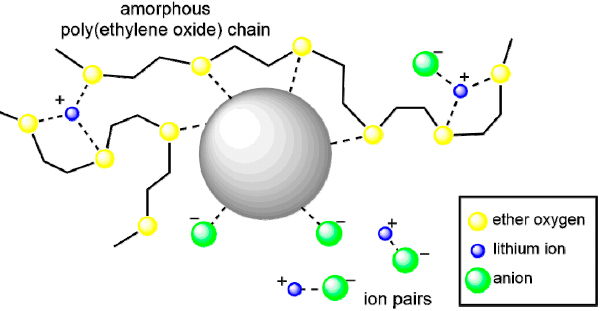
Figure 9. Schematic of Lewis acid-base interactions between a PEO–LiClO 4 electrolyte host and a nanoparticle guest.